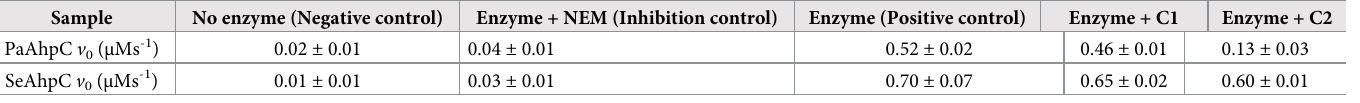
Table 2. Initial rates of hydrogen peroxide decomposition by PaAhpC or SeAhpC after treatment with compounds C1 or C2. Sample No enzyme (Negative control) Enzyme + NEM (Inhibition control) Enzyme (Positive control) Enzyme + C1 Enzyme + C2 PaAhpC v 0 ( μ Ms -1 ) 0.02 ± 0.01 0.04 ± 0.01 0.52 ± 0.02 0.46 ± 0.01 0.13 ± 0.03 SeAhpC v 0 ( μ Ms -1 ) 0.01 ± 0.01 0.03 ± 0.01 0.60 ±